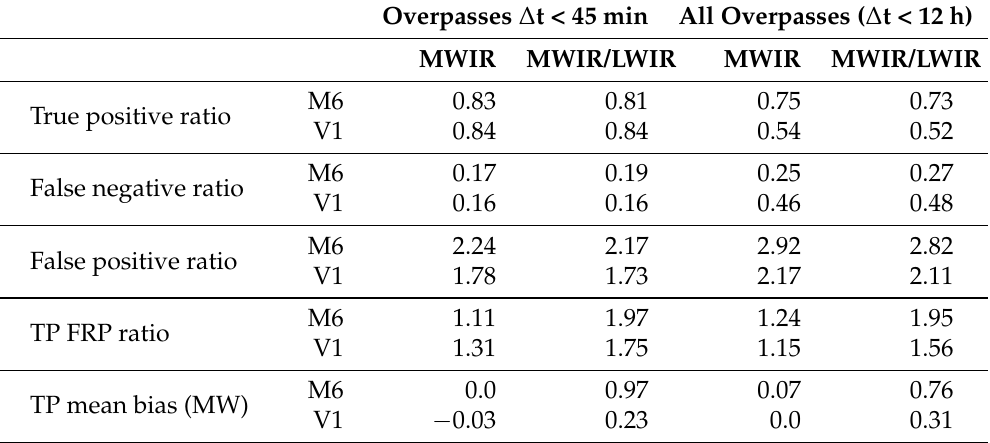
Figure 8. FireBIRD active fire data (derived using the MWIR method) and reference data for a fire event in New South Wales/Australia, November 2019. ( a ) shows active fires derived from two FireBIRD/HSRS overpasses (9 November 2019 and 14 November 2019), pigmented by FRP. ( b ) shows MODIS active fire data of the Aqua/Terra overpasses in closest temporal vicinity to the respective FireBIRD overpasses. ( c ) shows VIIRS active fire data of the Suomi-NPP overpasses in closest temporal vicinity to the respective FireBIRD overpasses. Background: Stamen/OpenStreetMap shaded terrain map. Table 3. Results of the inter-comparison between FireBIRD and the reference datasets, regarding both the subset and the complete dataset. M6 refers to the MODIS MOD14A1 product (version 6) while V1 refers to the VIIRS VNP14A1 product (version